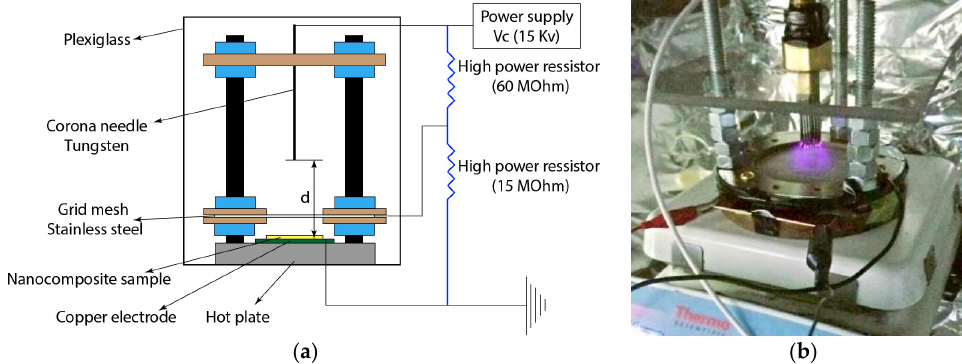
Figure 7. ( a ) Schematic of the corona poling; ( b ) Actual image of the corona poling process.